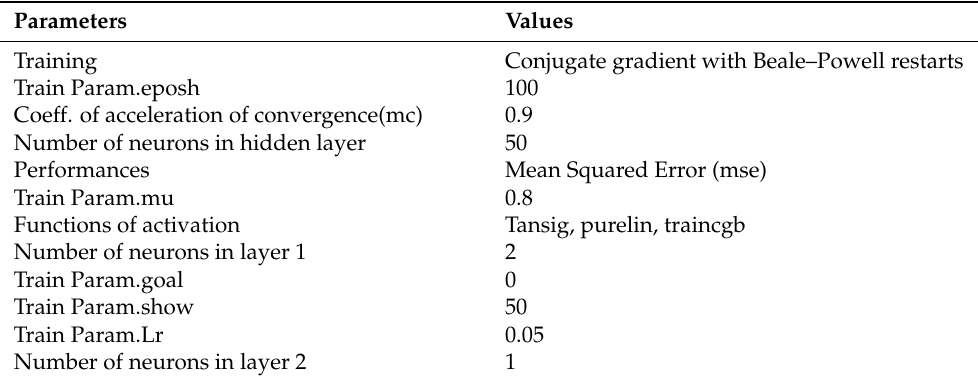
Table 1. Features of neural networks